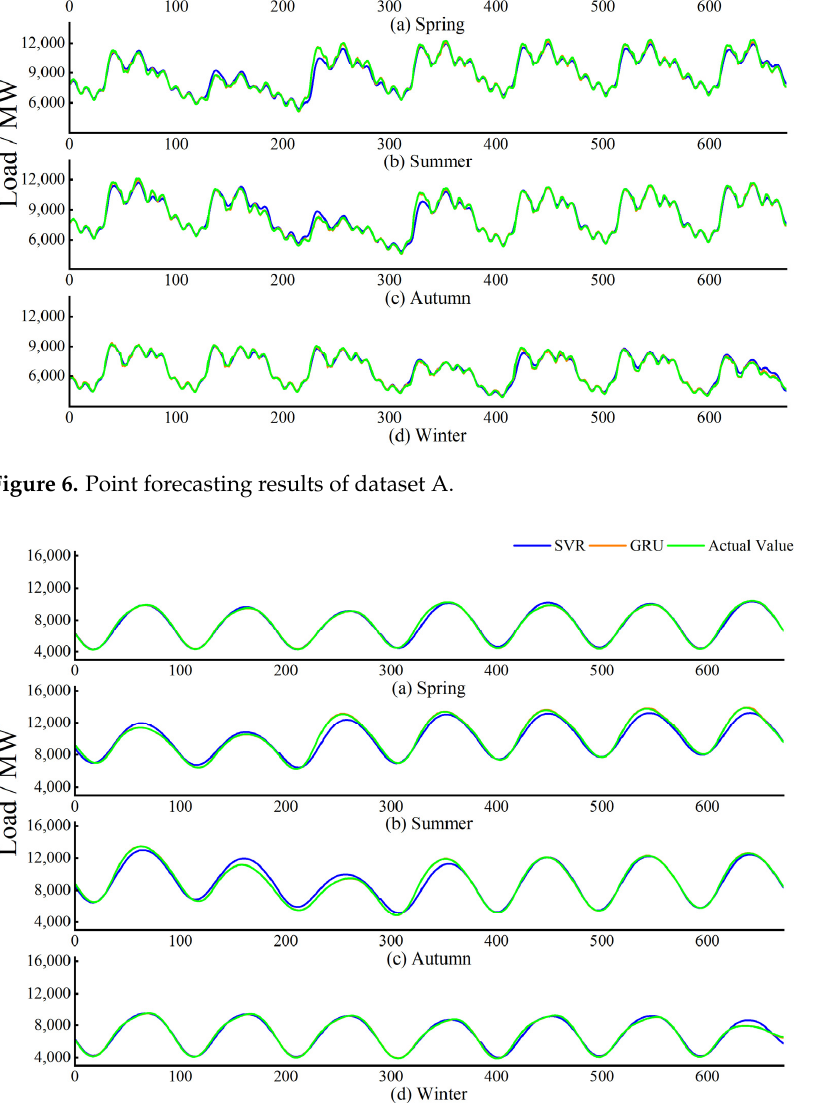
( b ) Figure 8. RMSE and MAE of model: ( a ) RMSE; ( b ) MAE. From Figure 8, it can be concluded that the accuracy of the GRU model is higher compared to the SVR model, whatever the season, where the root mean square error is reduced by at least 100 and the mean absolute error is reduced by at least 50. The errors are always much smaller than the SVR model, further demonstrating that the accuracy of the GRU model is much better than the SVR model.